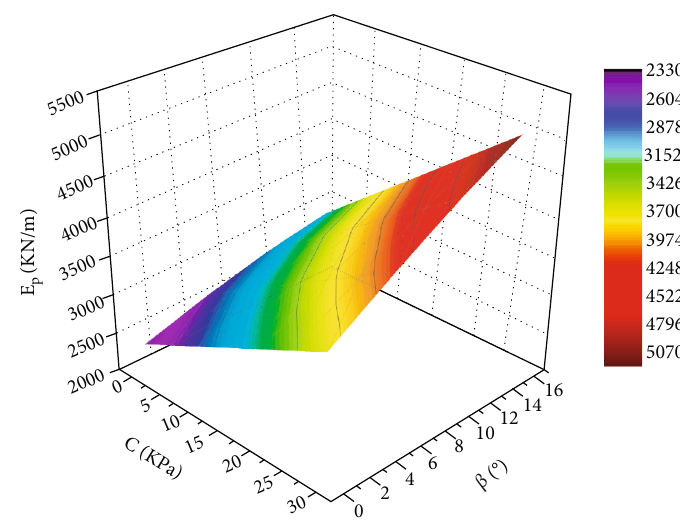
Figure 8: Change of active earth pressure with c and β